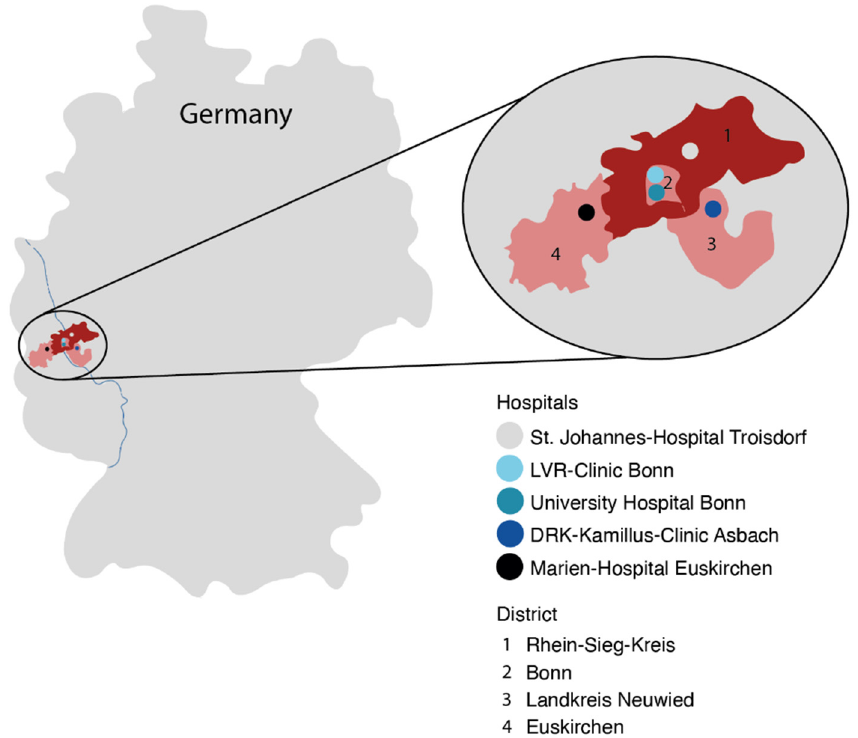
Figure 1. The neurovascular network “NeuroVask Bonn/Rheinland” (NVN) in Germany, consisting of neurology departments with acute stroke units, neuroradiology departments, cardiology departments, vascular surgery departments, and a neurosurgical department for neurosurgical intervention and treatment of patients with SAH in a metropolitan area with approximately 1.1 million inhabitants.